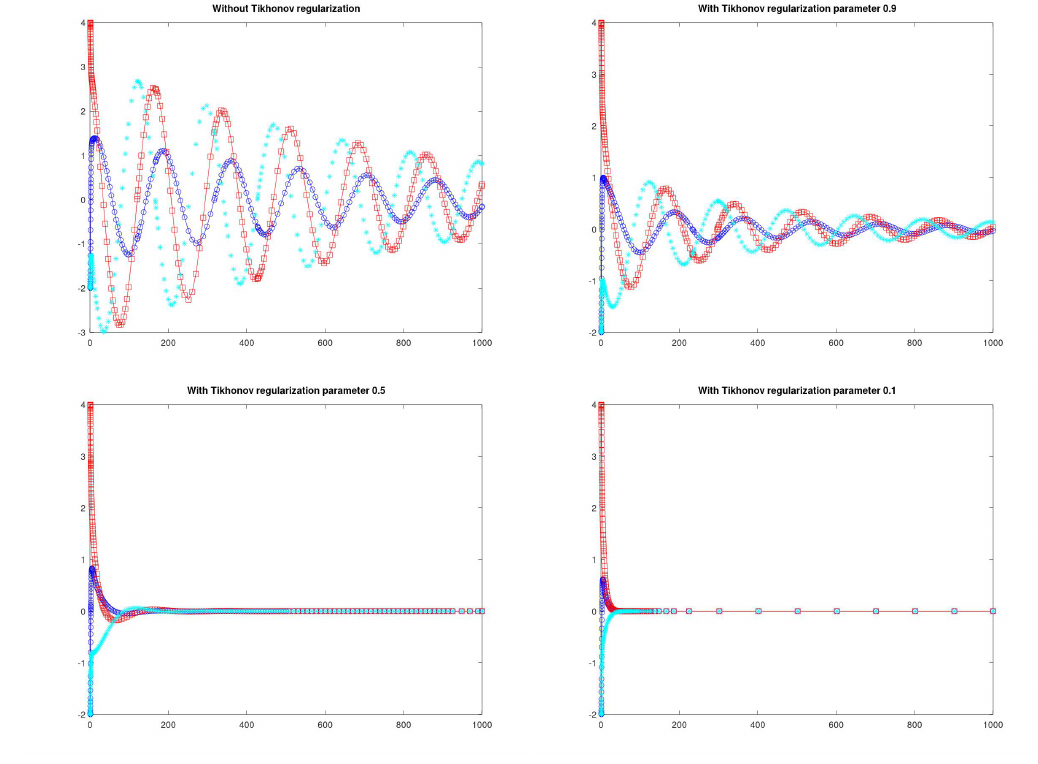
Fig. 6: Trajectories of ( FBFR ) for regularization parameters β ∈ { 0, 0.1, 0.5, 0.9 } and γ = 0.2